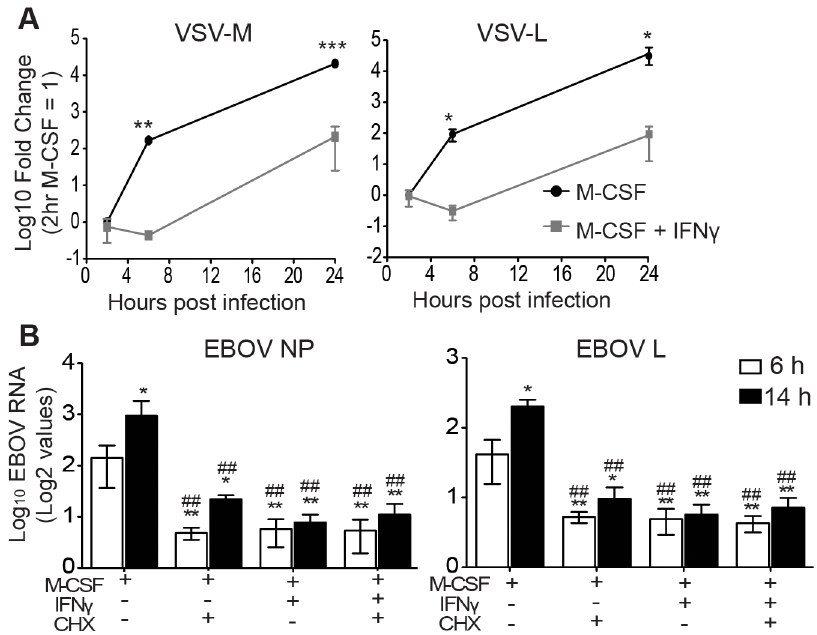
Fig 2. IFN γ blocks EBOV GP/rVSV and EBOV RNA synthesis. (A) M-CSF cultured peritoneal macrophages pre-treated for 24 hours with IFN γ have decreased EBOV GP/rVSV RNA synthesis at 6 and 24 hours following infection. Total RNA from IFN γ -treated or untreated peritoneal macrophages at indicated time points was assessed by qRT-PCR for VSV matrix (M) and polymerase (L) RNA. Log2 value of 2 hour M-CSF alone = 1 and data is shown as Log10 of the fold change. Significance was determined by one sample t-test compared to 2 hour M-CSF only control. * p < 0.05, ** p < 0.01, *** p < 0.001. (B) IFN γ treatment decreases EBOV RNA levels to the same extent as the protein synthesis inhibitor cycloheximide. Total RNA isolated at 6 or 14 hours following EBOV infection of M-CSF cultured peritoneal macrophages treated with or without IFN γ and/or CHX was quantified by qRT-PCR for EBOV nucleoprotein (NP) or polymerase (L) RNA. Data is shown as log2 values. Significance was determined by ANOVA with a Tukey post-test. * p < 0.05, ** p < 0.01 (compared to 6 hours M-CSF alone). ## p < 0.01 (compared to 14 hours M-CSF alone). ns, not significantly